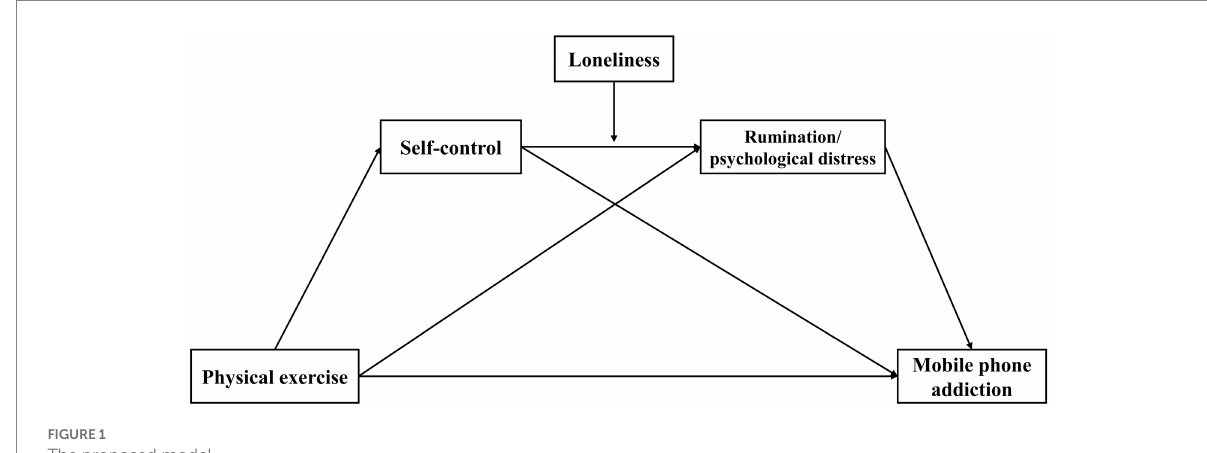
FIGURE 1 The proposed